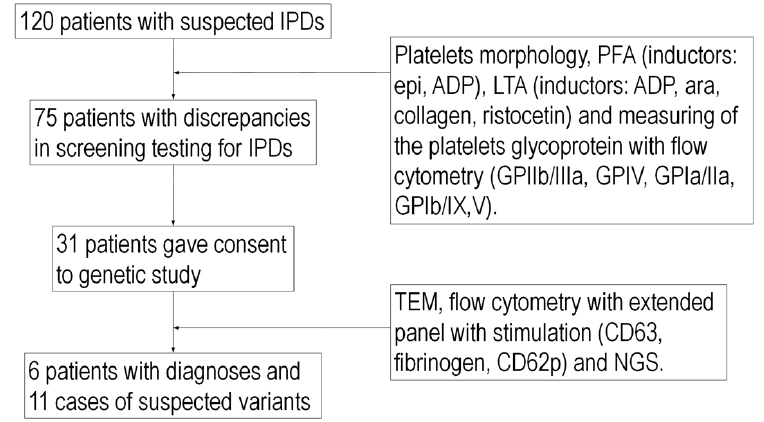
Figure 1. Overview of the study. Abbreviations: ADP—adenosine diphosphate, epi—epinephrine, ara—arachidonic acid, GP—glycoprotein.